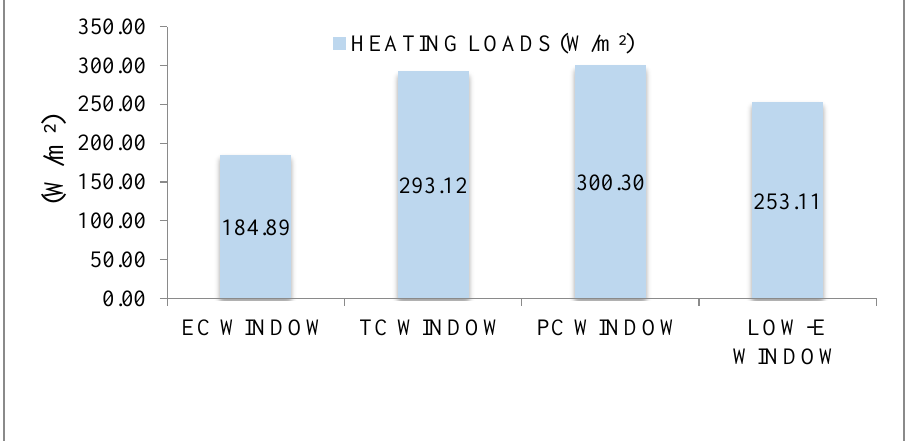
Figure 11 Total heating loads of the windows for February 12 in